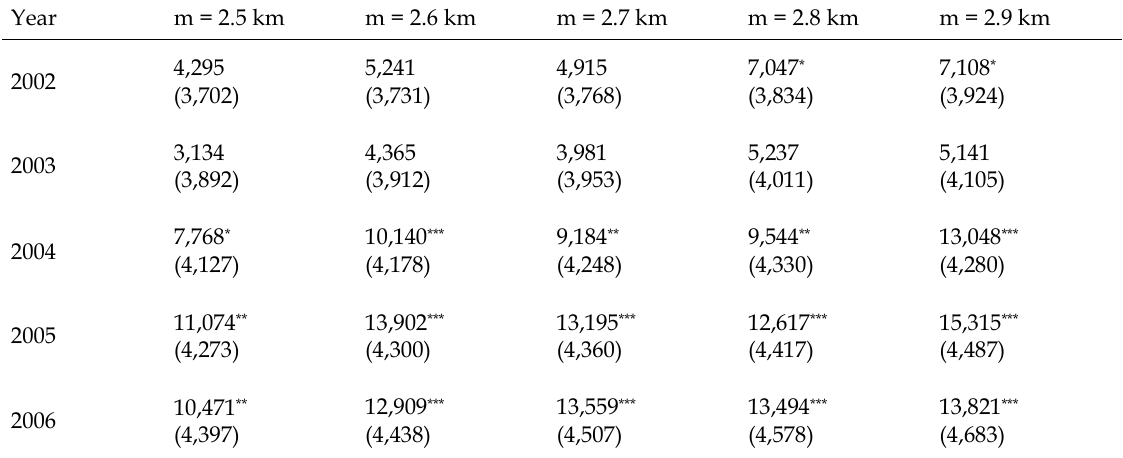
Table 3. Estimated post-treatment effect of improved job accessibility on earnings